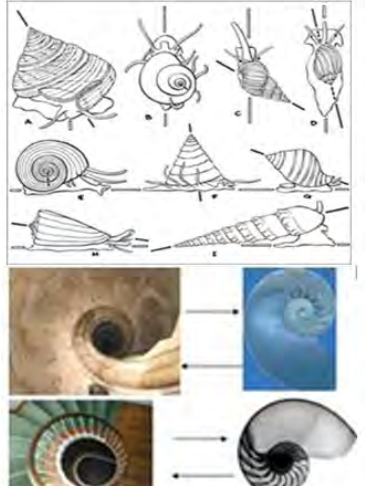
Figure 2. Showing the utilization of spire idea of seashells in making spiral stair case. Source: (Waddington & Whyte, 1968).